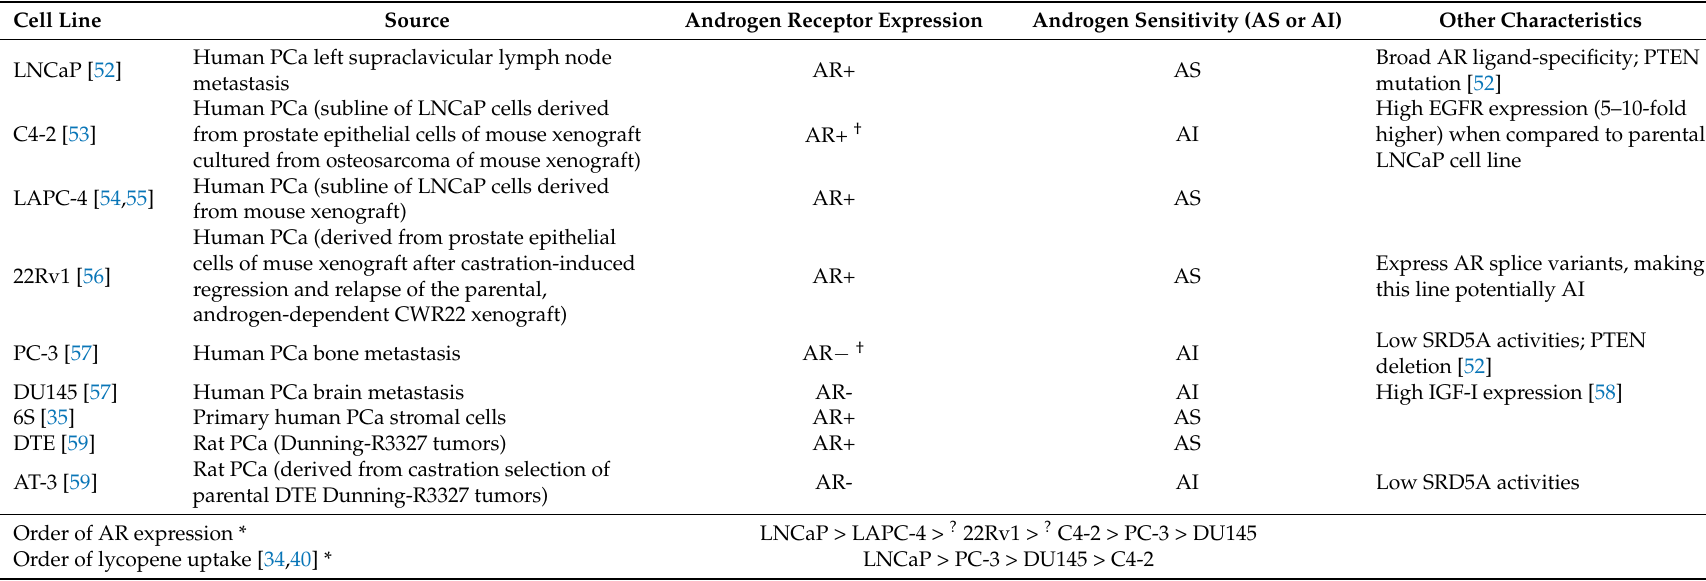
Table A3. Characteristics of prostate cancer cell